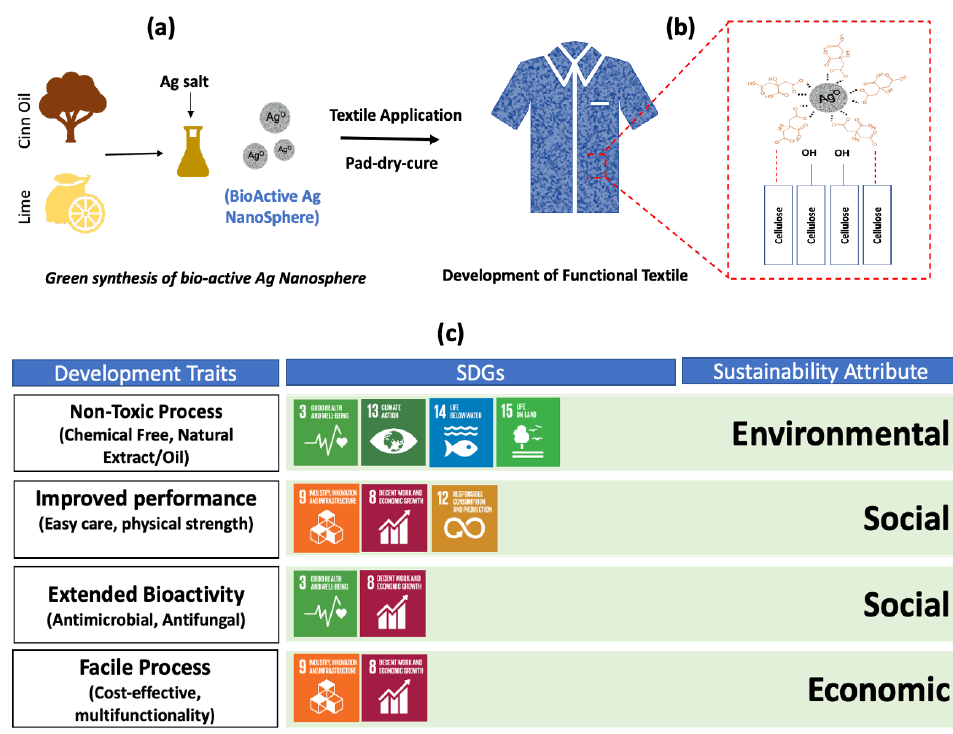
Figure 8. Utilization of bioactive silver nanoparticles for a sustainable functional textile: ( a , b ) devel- opment of functional textile with crosslinking mechanism; ( c ) eco-mapping of development traits with SDGs and sustainability attributes.